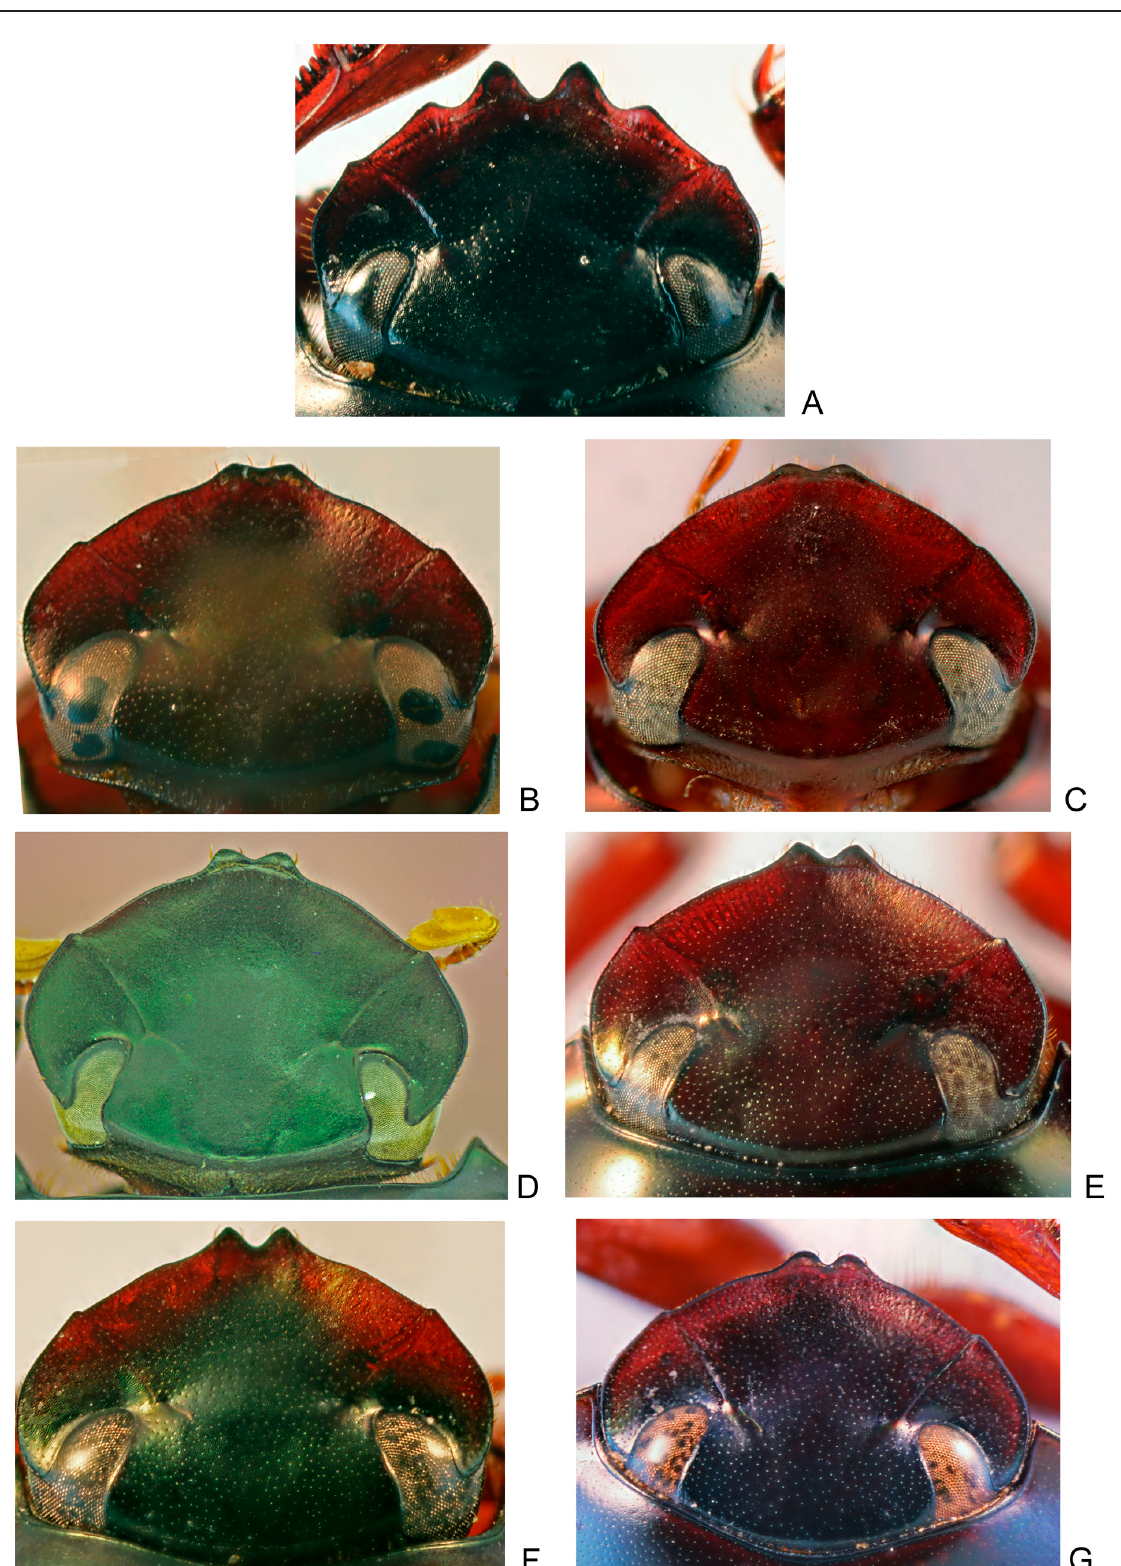
Fig. 6. Head, dorsal view. A . Sylvicanthon enkerlini (Martínez et al. , 1964) comb. nov. B . S.